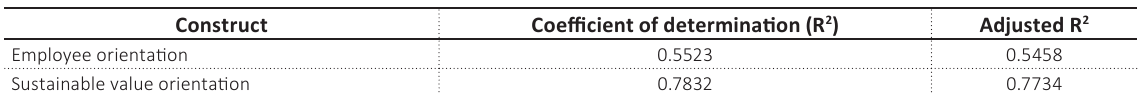
Table 6. Predictive power of the